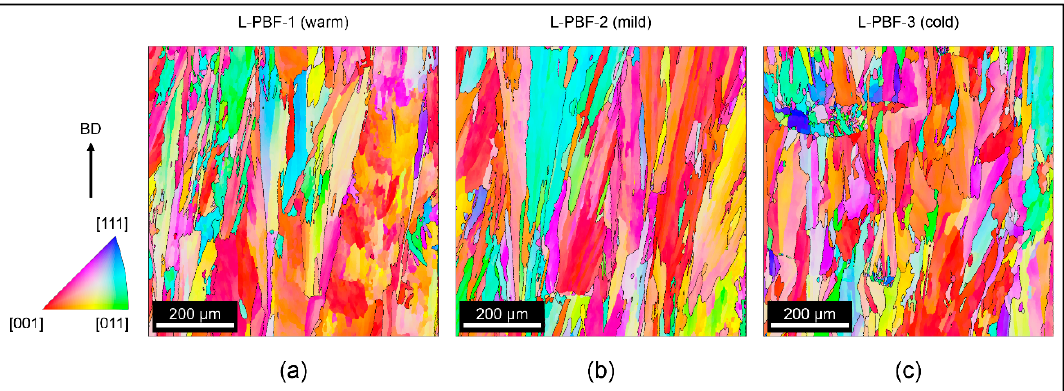
Figure 6. Electron backscatter diffraction (EBSD) map (with the building direction (BD) parallel to the [001] direction) of as-built ( a ) warm, ( b ) mild, and ( c ) cold L-PBF conditions, showing strong concentrations in [001] directions along the BD. Similar columnar grain structures are shown with aspect ratios of 2.3, 2.2, and 1.9 (intercept method).